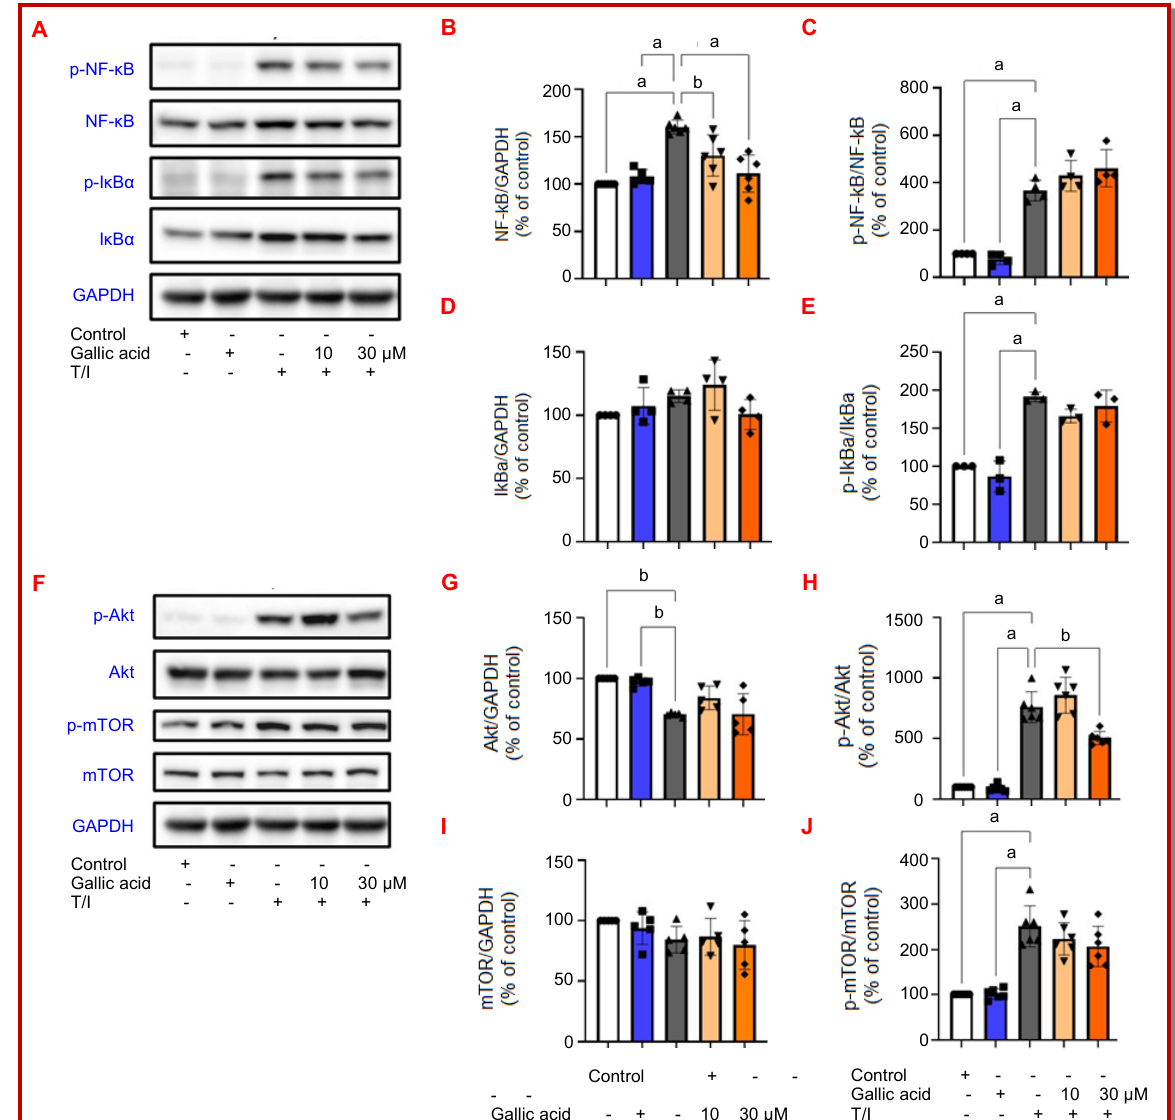
Figure 4: Effects of gallic acid on total and phosphorylated protein levels of IkBa, NF-kB, Akt and mTOR in HaCaT keratinocytes. HaCaT cells were treated without (control) and with different concentrations of gallic acid in the presence of 10 ng/mL recombi- nant human TNF- α and 10 ng/mL IFN- γ (T/I) for 24 hours. Protein expression levels of I κ Ba, p-I κ Ba, NF κ B, p-NF- κ B, Akt, p-Akt, mTOR, and p-mTOR in HaCaT cells were determined using western blotting analysis. GAPDH was used as a reference and the amounts of different proteins were normalized to that of GAPDH. Data are presented as a percentage of control group values (mean ± SD of three to six independent experiments). a p<0.0001 and b p<0.01 indicate a significant